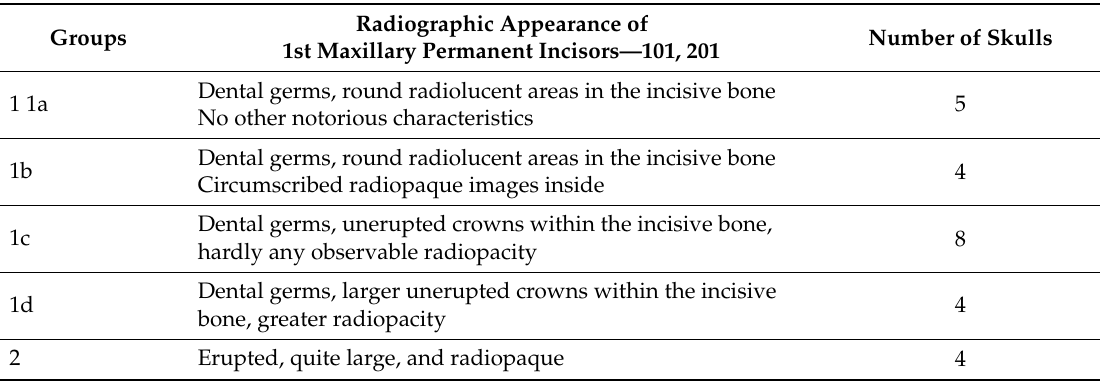
Table 1. In 25 skulls of Spanish horses, most remarkable radiographic characteristics of 1st permanent maxillary incisors—101, 201—and number of skulls studied. Groups 1a to 1d, estimated age of between 12 and less than 30 months. Group 2, estimated age between 30 and 42